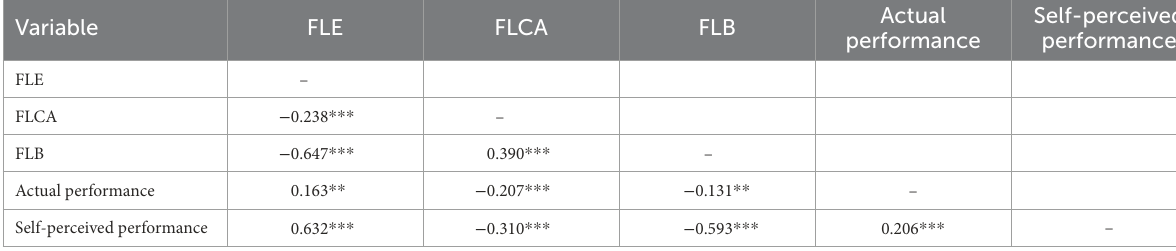
TABLE 3 Correlations between FLE, FLCA, FLB, and online learning performance for reading-and-writing group. Variable